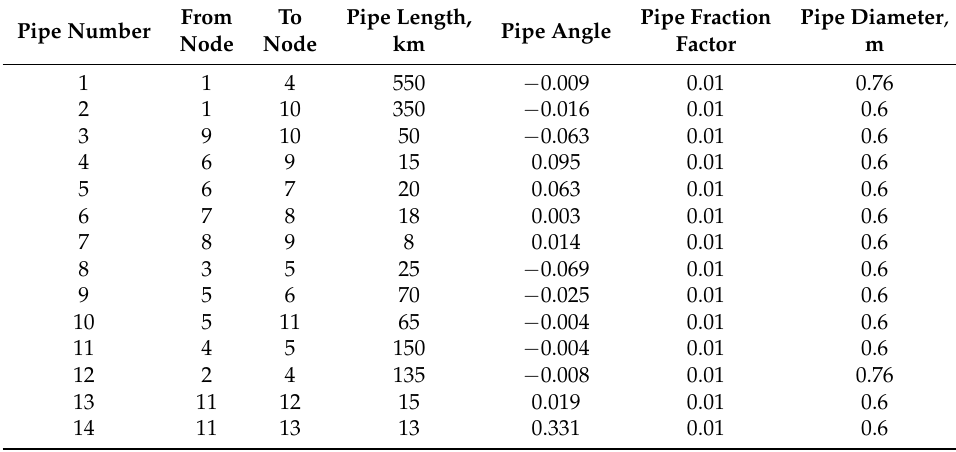
Table 1. Parameters of the gas flow equation in the small network with 13 nodes and 14